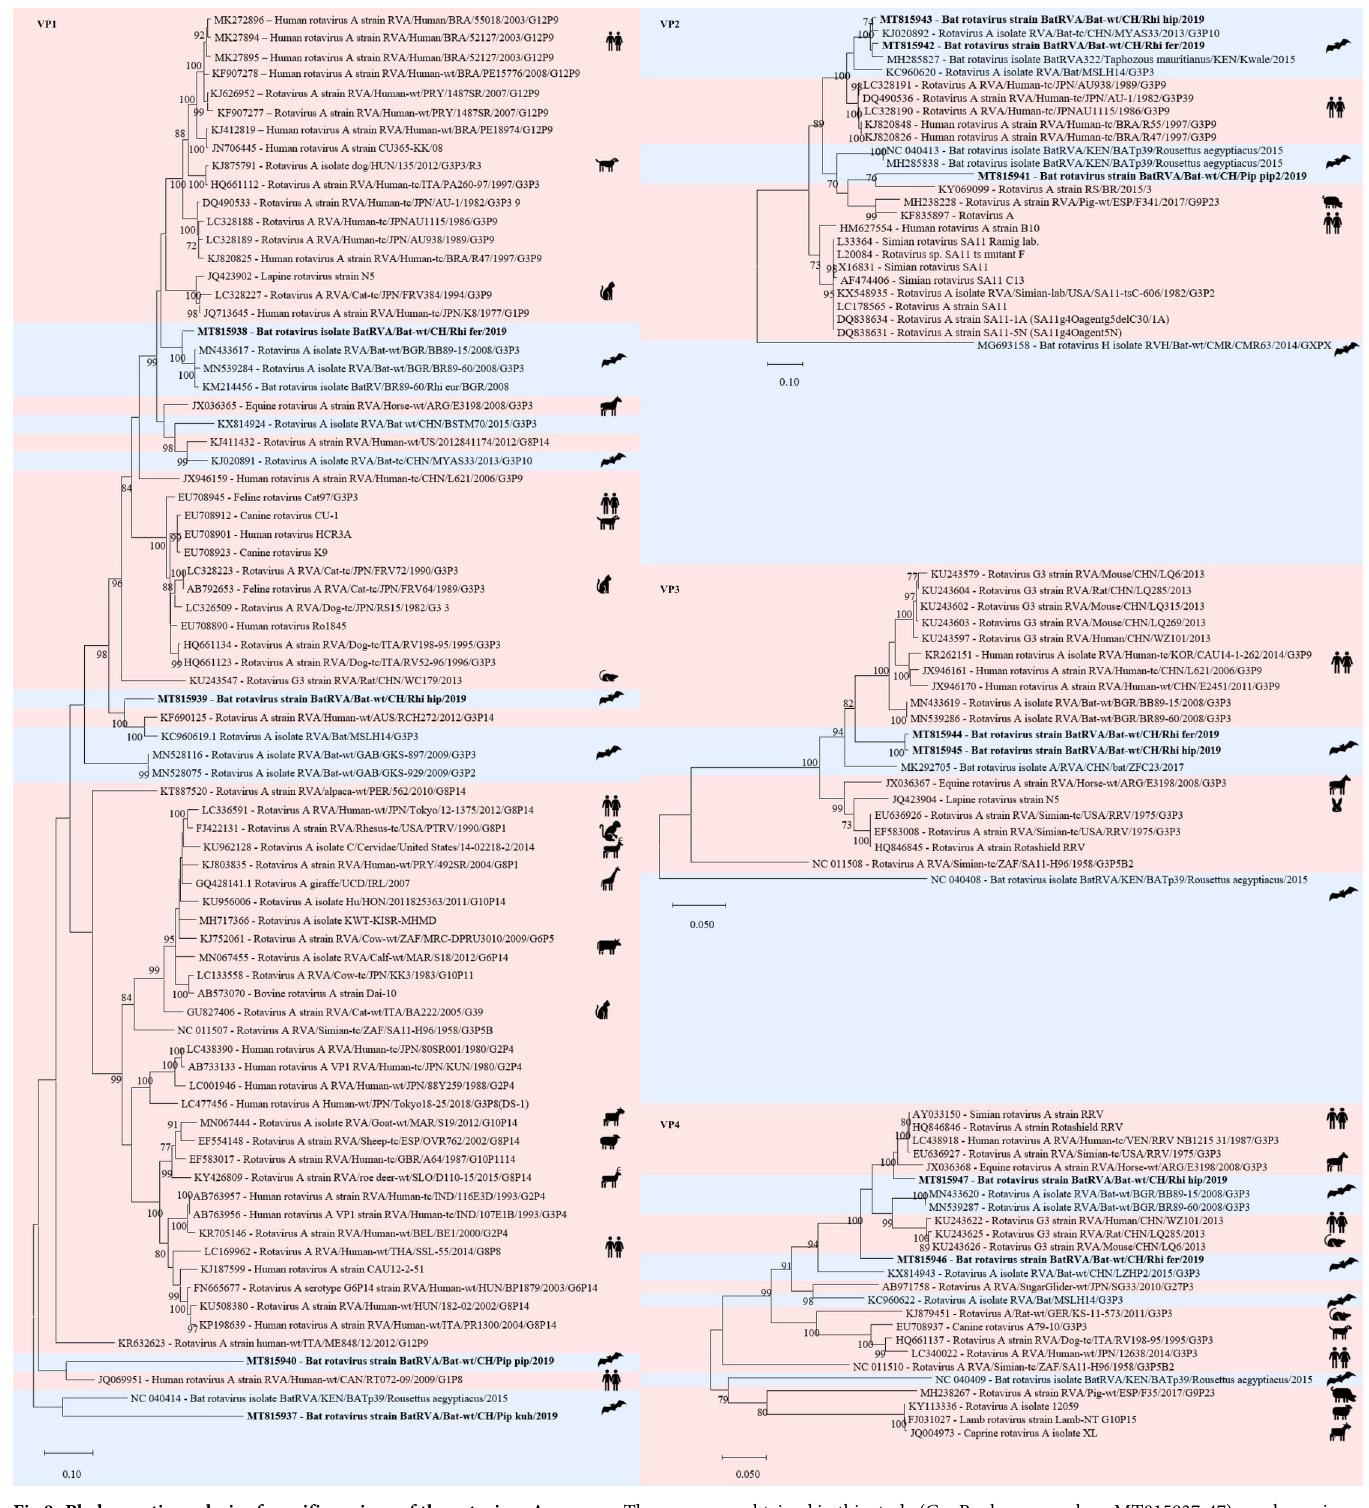
Fig 8. Phylogenetic analysis of specific regions of the rotavirus A genome. The sequences obtained in this study (GenBank acc. numbers MT815937-47) are shown in bold. Sequences of non-bat associated viruses are marked with a red background and those of bat associated viruses with a blue background. The pictograms on the right side represent the species in which the virus was detected. Sequences were aligned using Muscle. For phylogenetic analysis, the Maximum likelihood tree with 1’000 bootstraps was used. Only values � 70% are displayed.